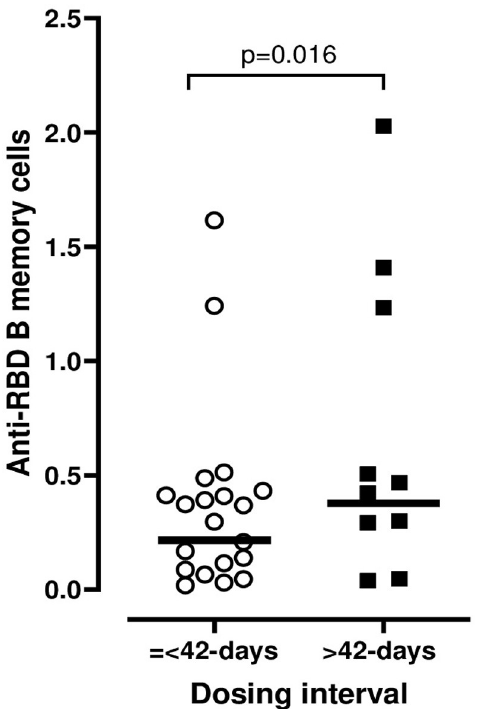
Fig 6. Anti-RBD memory B cells at 3 months according to dosing interval = < 42 days or > 42 days between doses. In 30 random participants anti-RBD IgG specific B memory cells were measured using commercially available ELISPOT kit (Mabtech). Data are plotted for participants with dosing interval = < 42 days ( < 35-days and 35-42-days groups combined) and > 42-days group with the adjusted mean provided for each group. Comparison was performed using linear mixed effects model adjusted for age, sex, education, smoking, alcohol use, body-mass index, known comorbidities (cardiovascular, neoplastic, autoimmune, renal and chronic respiratory diseases) and the number of days after 2 nd vaccine dose to subsequent blood